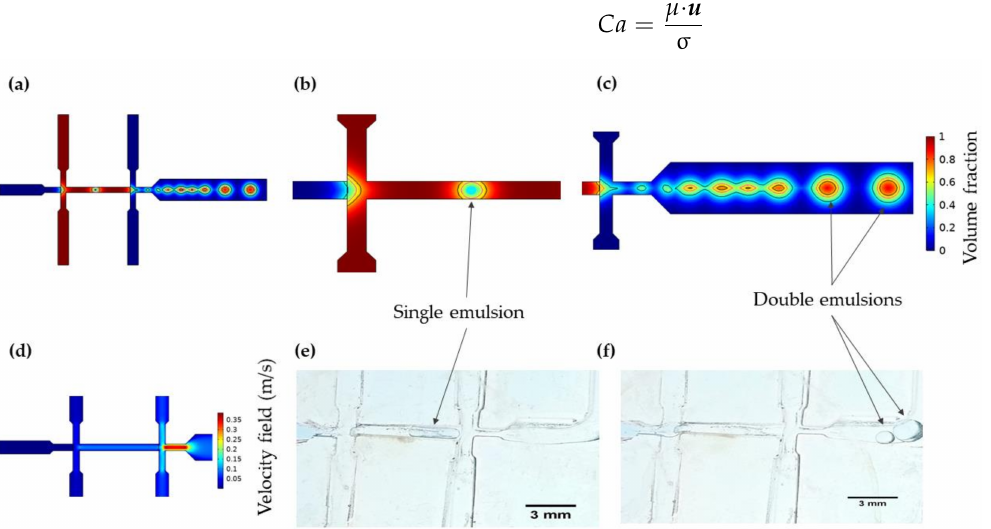
Figure 4. Simulation results for double emulsion generation and experimental visualization via digital microscopy. ( a ) Dispersed phase volume fraction in two-step double emulsion formation. ( b ) Single emulsion formation within the first flow-focusing unit with contours indicating inner continuous phase (black) surrounded by dispersed phase (red domain). ( c ) Double emulsion formation at the second flow-focusing unit with contours indication inner aqueous phase (black) and dispersed phase (magenta) surrounded by outer continuous phase (blue domain). ( d ) Velocity profile for a 1:10:30 FRR. ( e ) Experimental single and ( f ) double emulsion formation with the assembled microfluidic